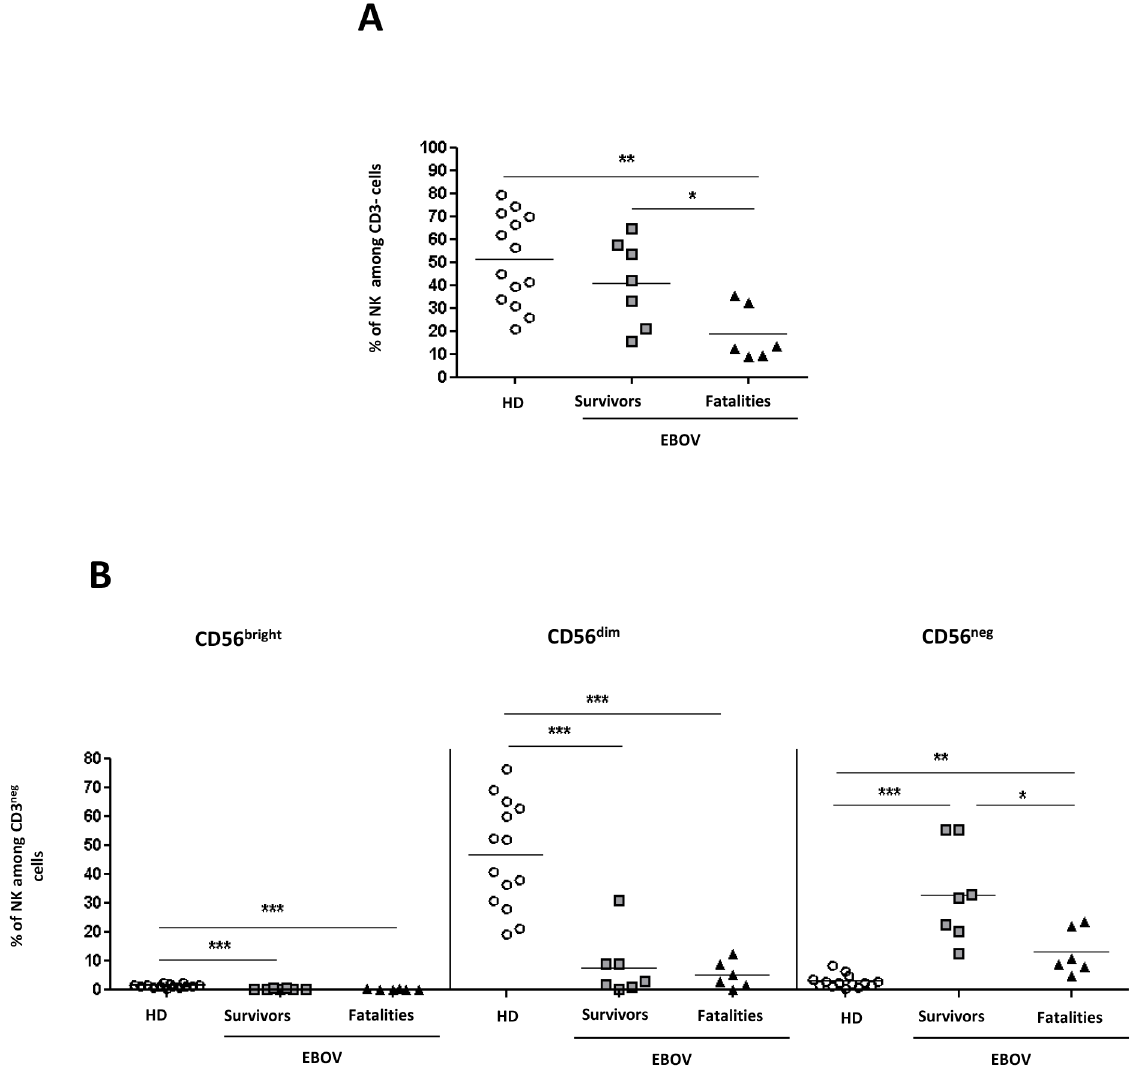
Fig 2. NK cells in survivors and in fatalities. The frequency of NK ( A ), and of NK subsets ( B: CD56 bright , CD56 dim , and CD56 neg ) was analyzedin HD (n = 14), EBOV-survivors (n = 7) and EBOV-fatalities (n = 6). Statistical analysiswas performed by using Mann Whitney test and differences were consideredsignificantwith a p < 0.05,and highlightedwith an asterisk.. * : p < 0.05; ** : p < 0.01; *** : p < 0.001.